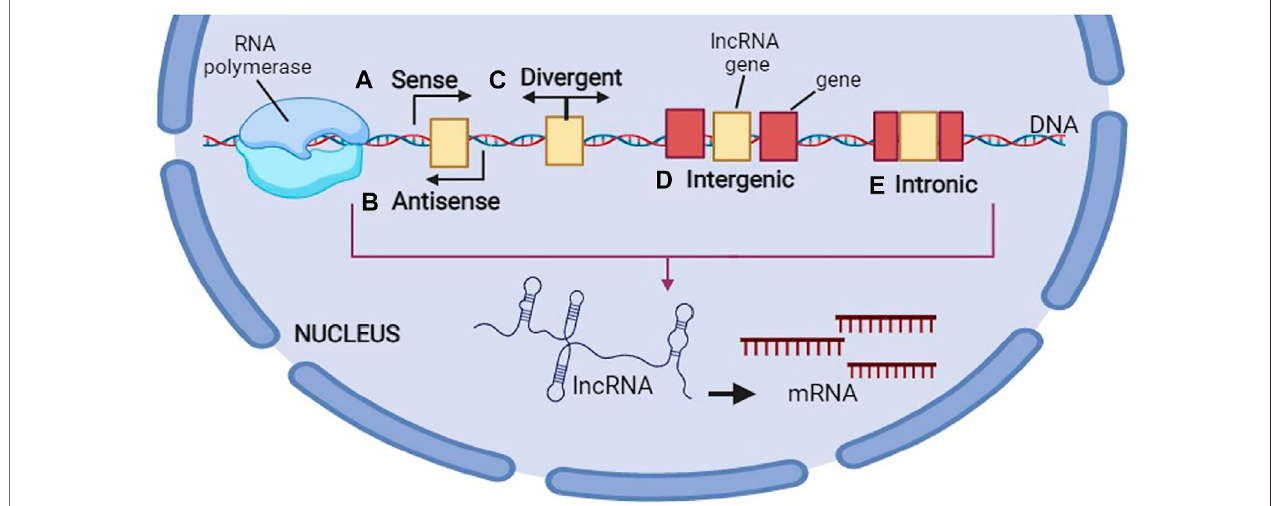
FIGURE 3 | Biogenesis of long non-coding RNA (lncRNA). This fi gure is created by www.BioRender.com.